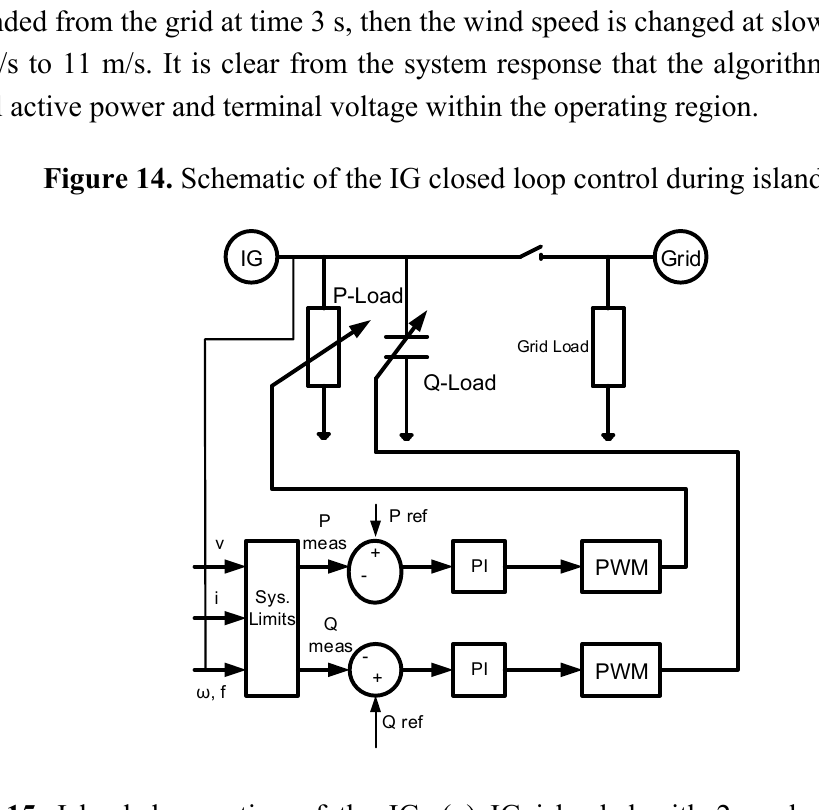
Figure 15. Islanded operation of the IG. ( a ) IG islanded with 2 pu local active load; ( b ) IG islanded when active local load is lower than rated value; ( c ) IG islanded under different wind